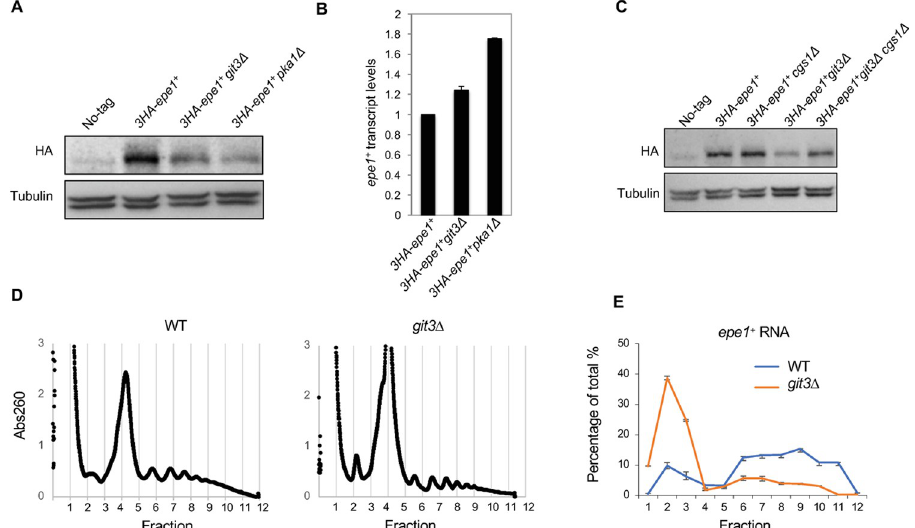
Fig 4. The cAMP signaling pathway regulates the protein levels of endogenous Epe1. (A, C) Western blot analysis to measure the levels of endogenous 3HA-tagged Epe1 and tubulin. (B) RT-qPCR analysis of epe1 + transcript levels, normalized to act1 + . Error bars represent SD. n = 2. (C) Sucrose density gradients of ribosomes in each strain with continuous monitoring of absorbance at 260 nm. Lighter fractions are on the left. (E) qRT-PCR analysis of epe1 + transcripts from each fraction. Relative amounts of transcripts were calculated using the delta Ct method. The distribution is shown as a percentage of the total. Error bars represent the SD of two technical replicates.